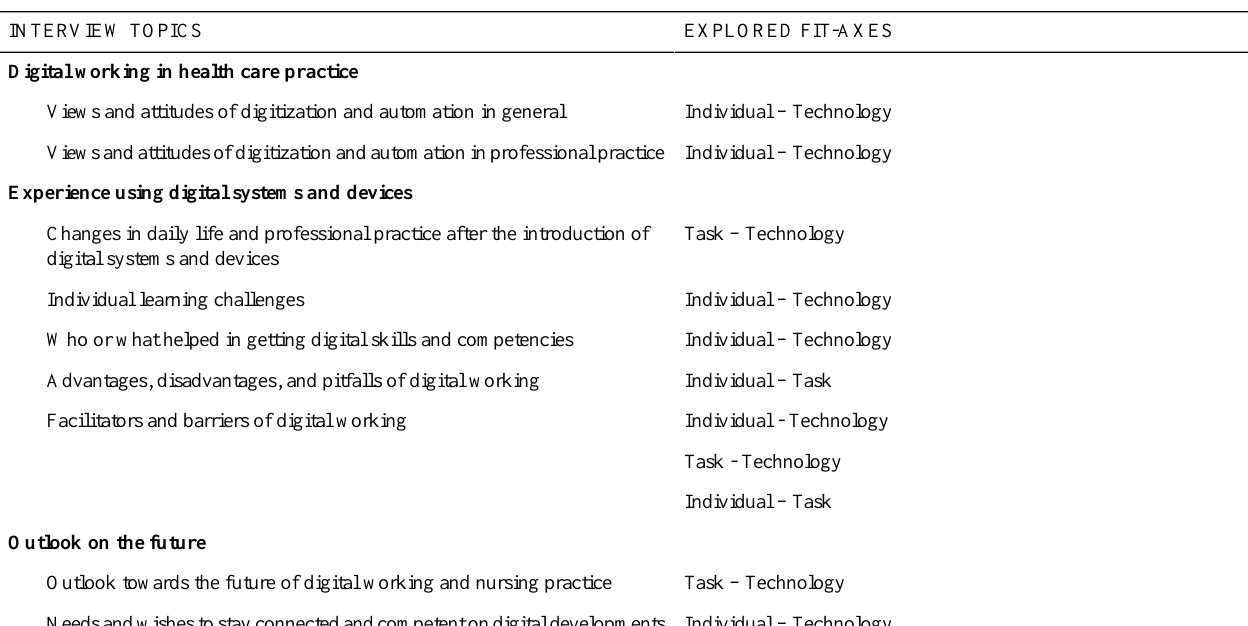
Table 1. Interview topic list compared with the FITT-framework fit-axes; FITT: fit between Individual, Task, and Technology.